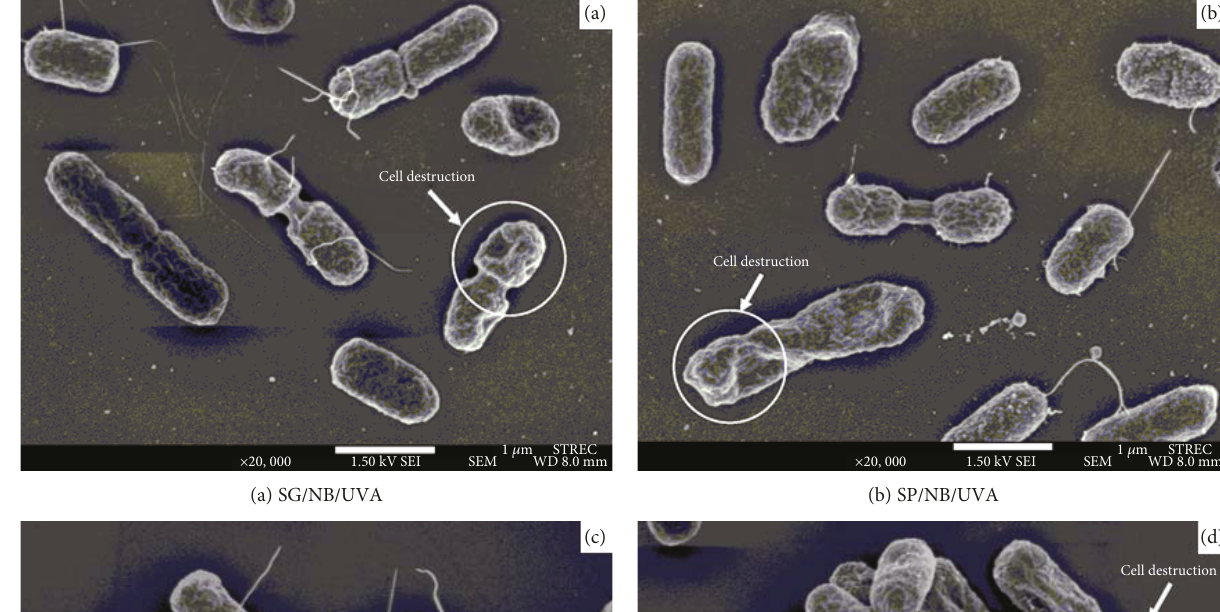
thin fi lms and UVA 2